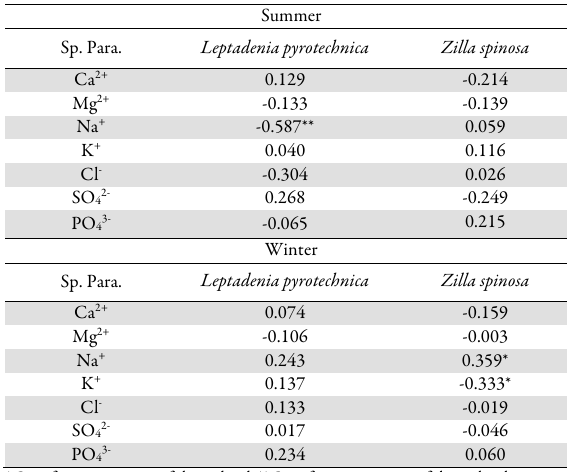
Table 6. Correlation coefficient values (r) between the internal mineral elements in the Zilla spinosa and Leptadenia pyrotechnica and their contents in the soil samples in both summer and winter